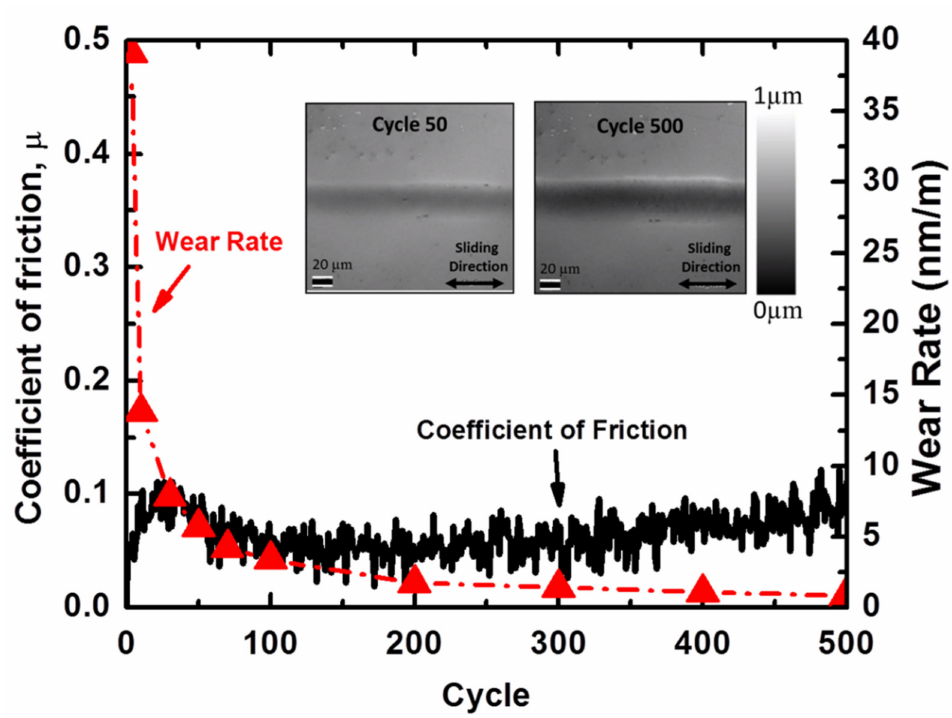
Figure 2. Coefficient of friction and wear rate vs. cycle for diamond sliding against tungsten under unlubricated conditions using a macro-scale tribometer.